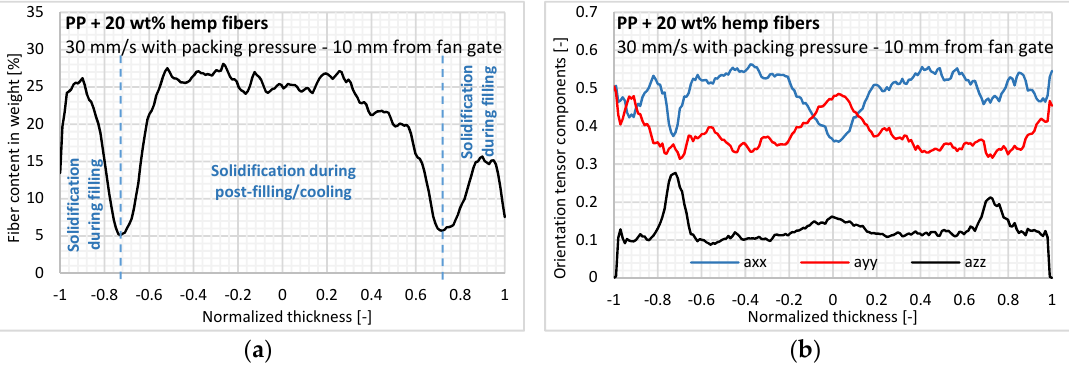
Figure 6. At the cavity entry region, measurement of ( a ) fiber content and ( b ) three components of the second-order orientation tensor inside the sample normalized thickness (a xx : Flow; a yy : Cross-flow; a zz : Thickness).